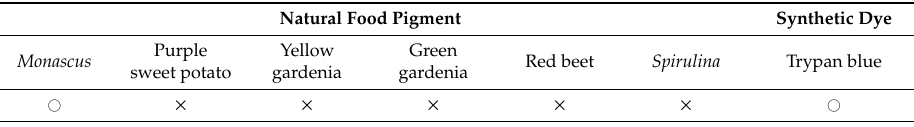
Table 3. Pigment usable / unusable for viability